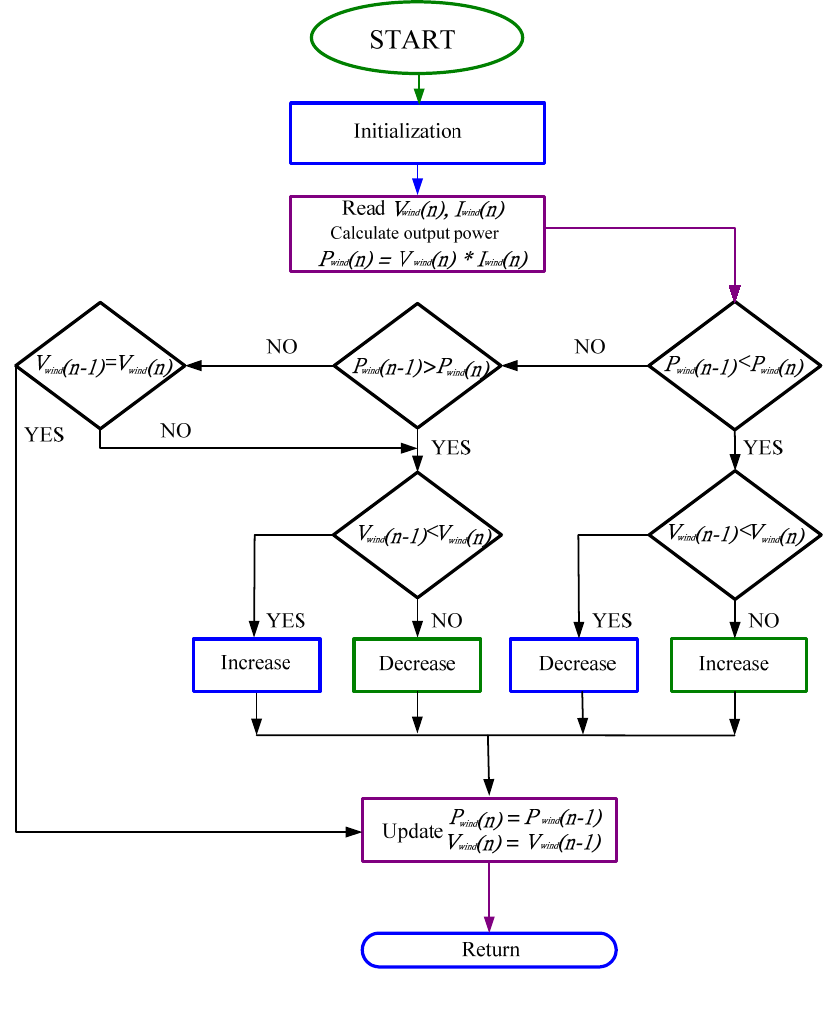
Figure 12. Flow chart of perturbation and observation method for MPPT